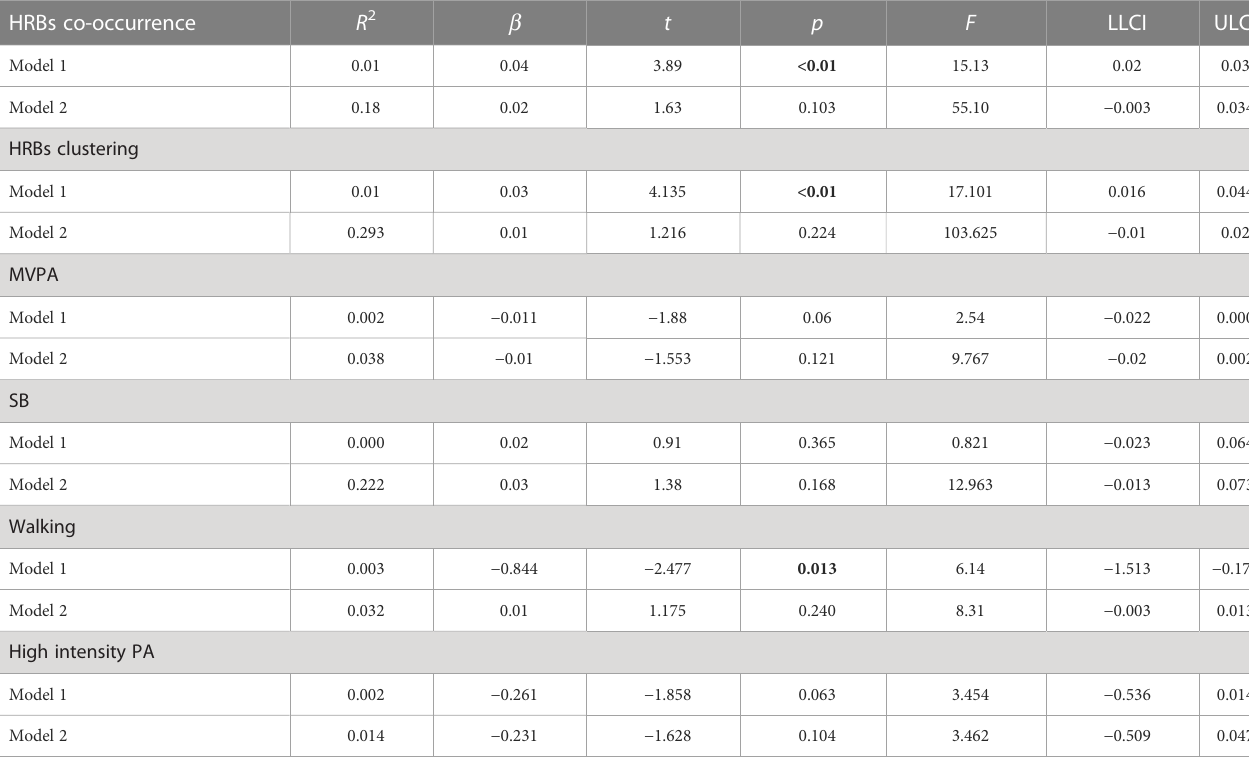
TABLE 3 The multilevel linear regression between health risk behaviors (numbers) and zMS. HRBs co-occurrence R 2 b t p F LLCI Model 1 0.01